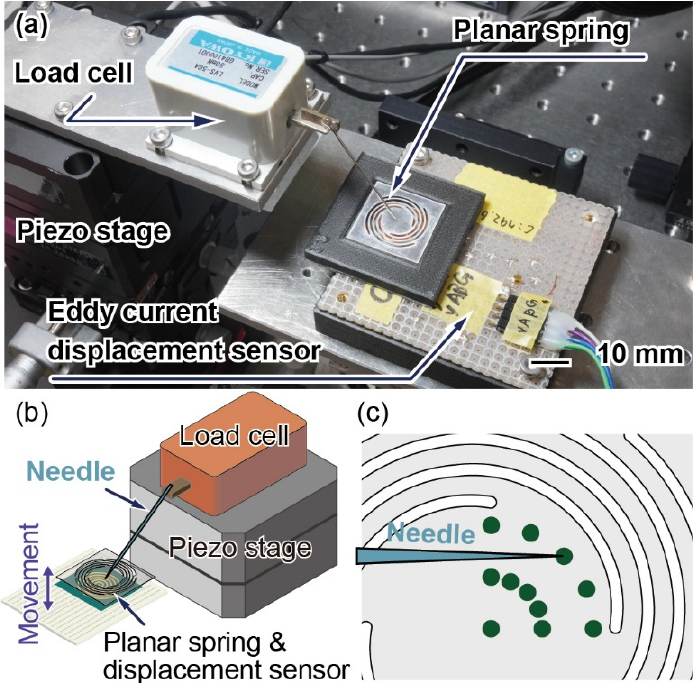
Figure 9. ( a ) Photograph and ( b ) concept sketch of the experimental setup for calibration and evaluation of sensitivity variation. ( c ) 11 points pushed on the planar spring.